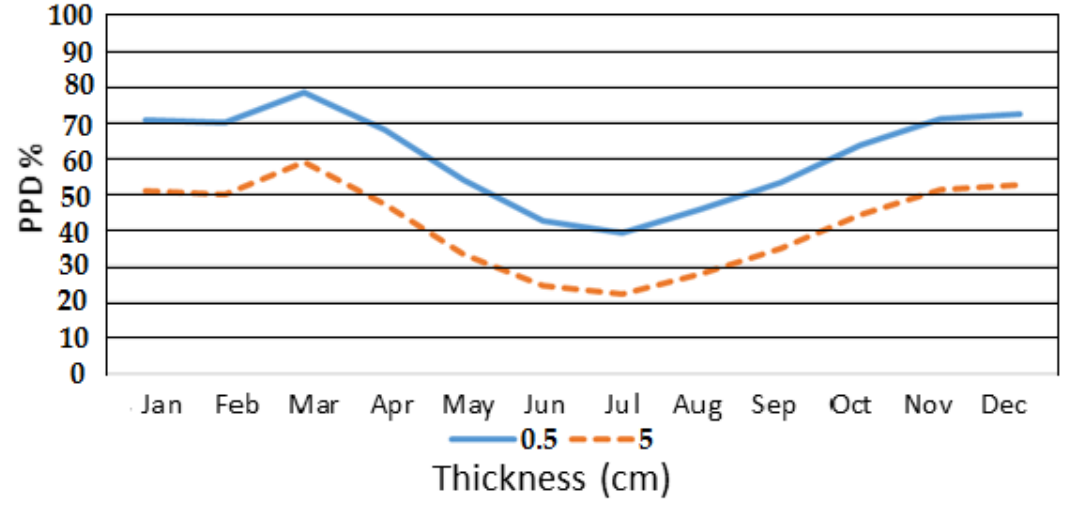
Figure 4. PPD (%) for 2 thicknesses of the PU insulation used on the roof in Recife,